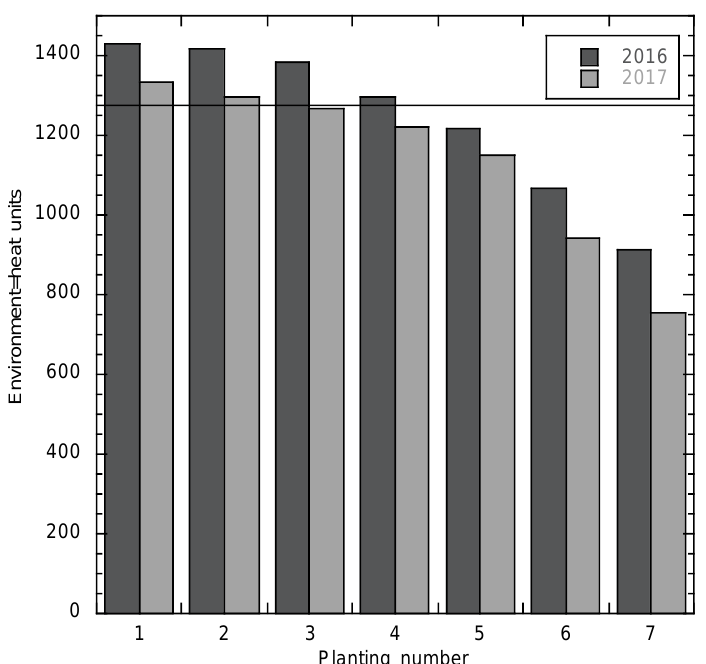
Figure 11. Accumulated environment-heat units for seevn plantings/year in 2016 and 2017. Environment-heat units represent heat units (15.5 °C base) that accumulated between the planting date and November 20 in each year. The horizontal line indicates 1250 heat units that are a putative benchmark for crop maturity. Plantings 1 through 3 in 2016 were lost to a hailstorm and never reached maturity date.